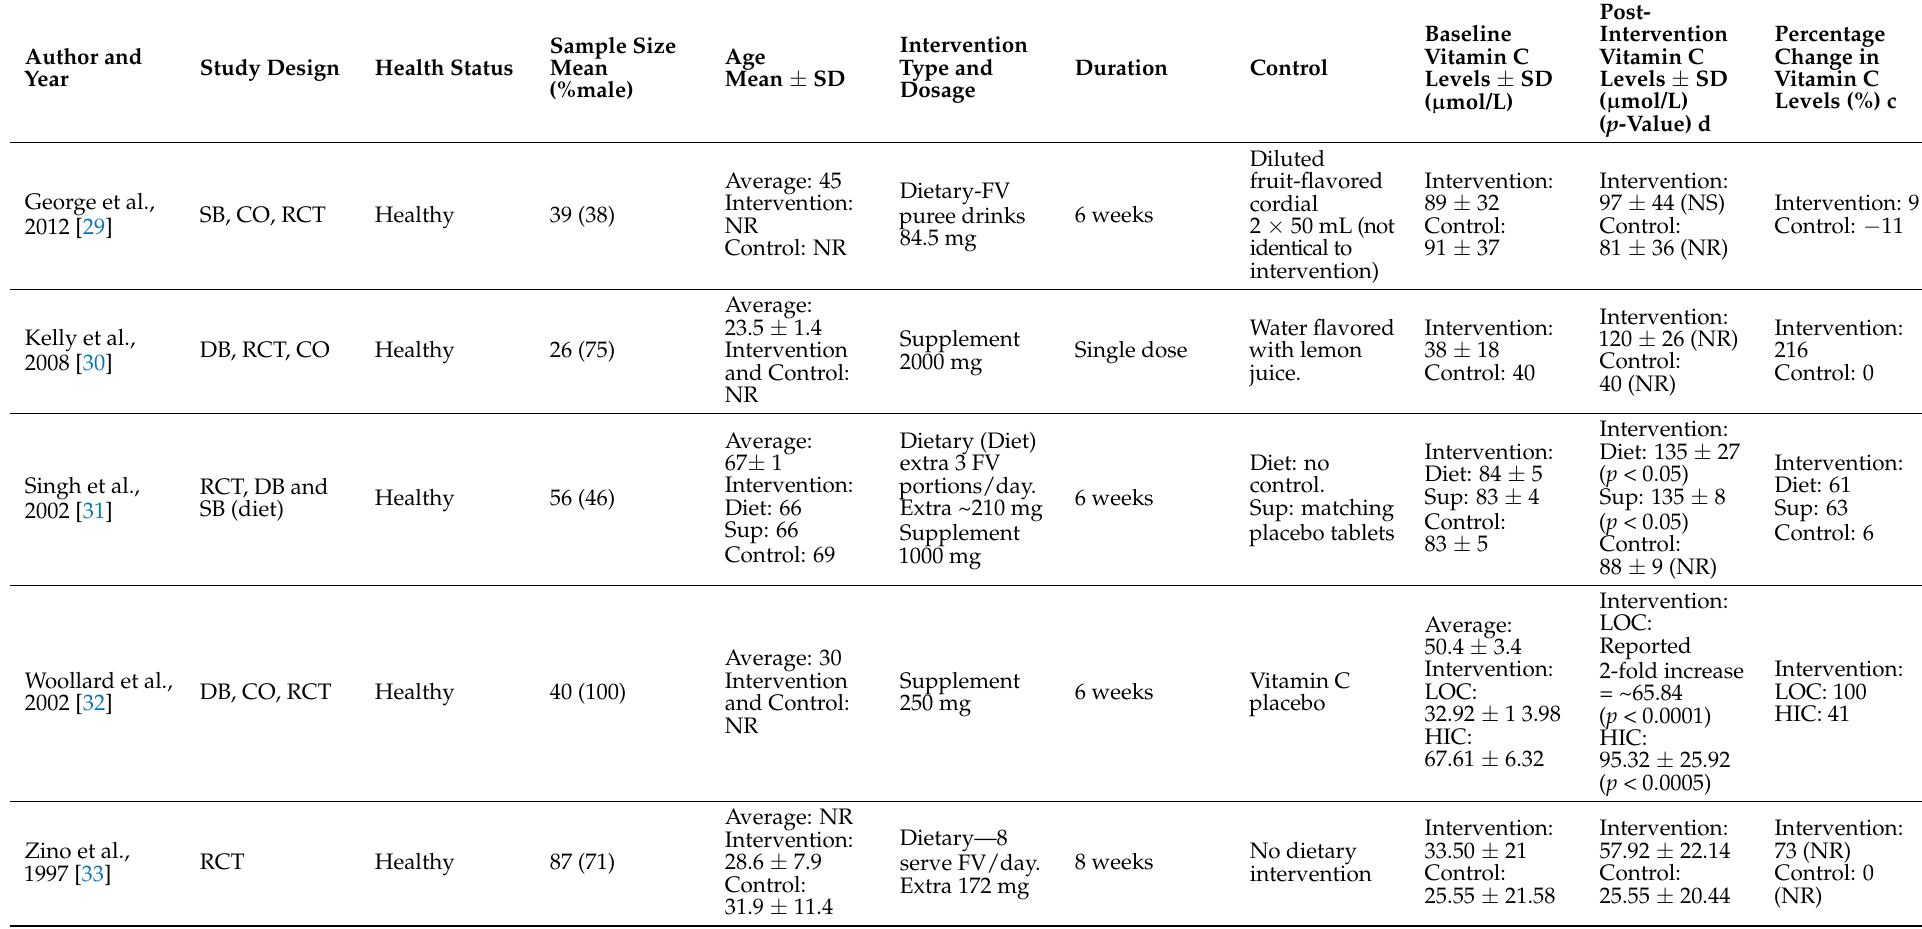
Table 4. Data summary table of studies investigating vitamin C intake and vitamin C levels in the healthy